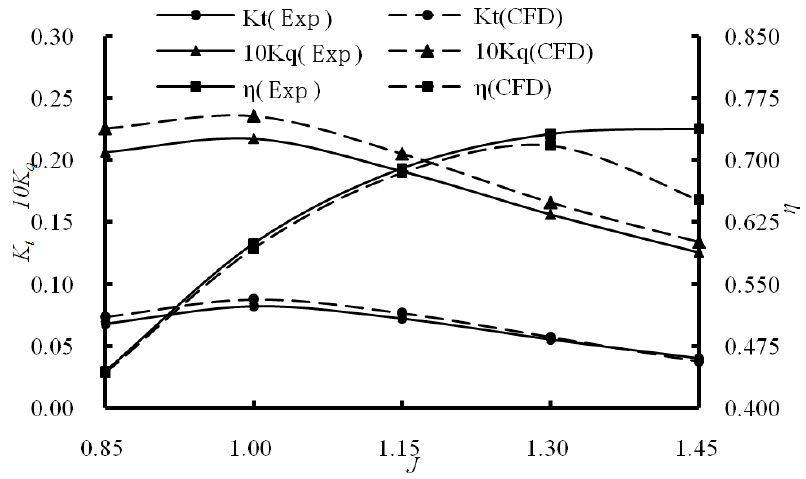
Figure 5. Comparison of CFD and experimental results at It = 1/3.